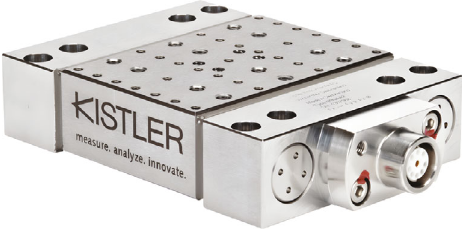
Figure 9: Kistler 9119AA2 force